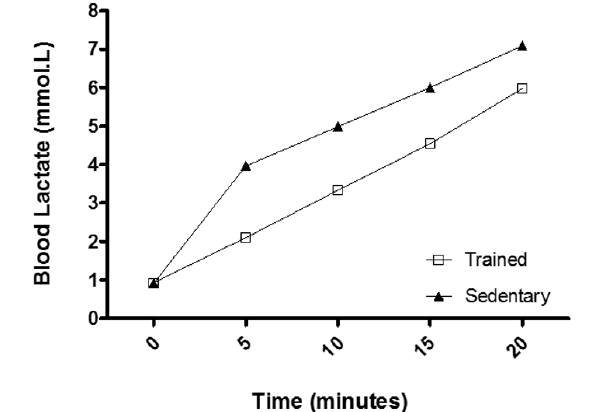
Figure 6. Blood lactate concentration vs exercise time of one rat after physical training (same as Figure 3 and 5) and one (the only rat that completed the test) remained sedentary (8 weeks) during constant load test carrying out load above LMI obtained by post-training LACmin